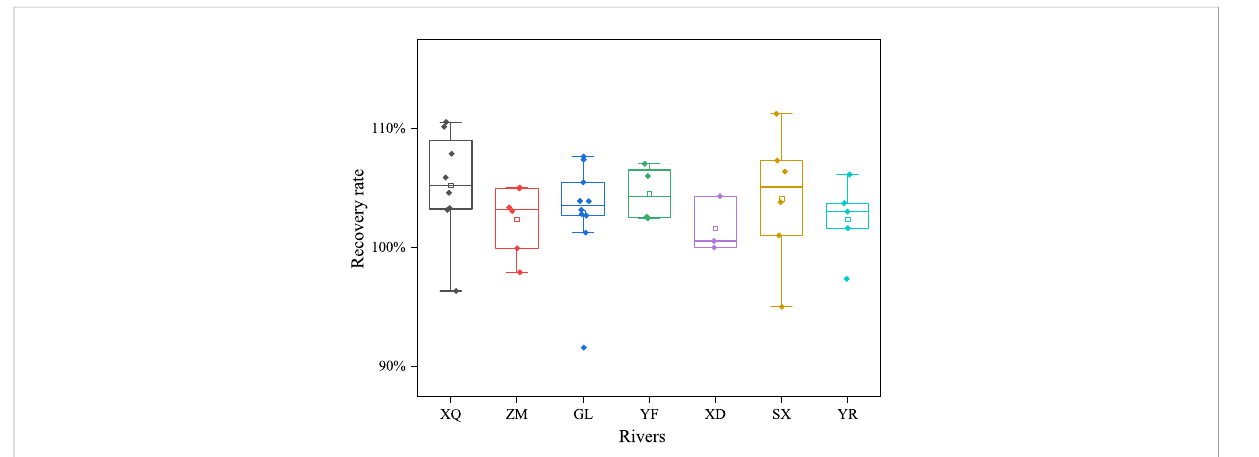
FIGURE 3 The mass balance of lead (Pb) in different rivers. XQ represents the Xiaoqinghe River; ZM represents the Zhimaihe River; GL represents the Guanglihe River; YF represents the Yongfenghe River; XD represents the Xiaodaohe River; SX represents the Shenxiangou River; and YR represents the Yellow